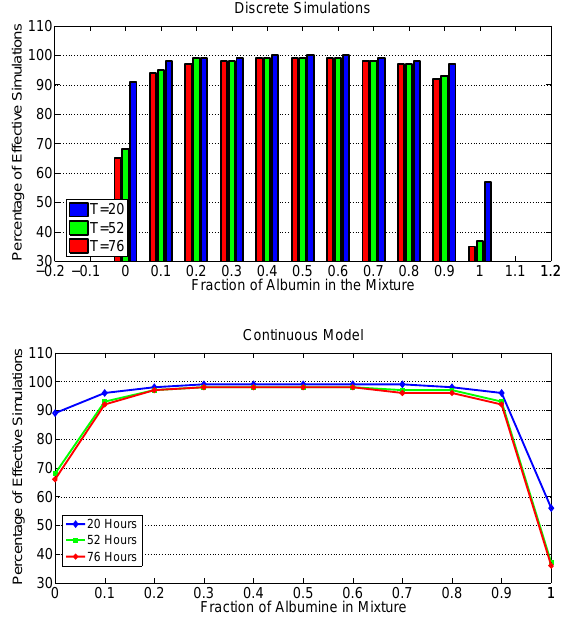
Fig. 3. Effects of different doses of antibiotics on bacterial growth on the surface of an implant. Discrete (above) and continuous (below) models results for T = 76 .